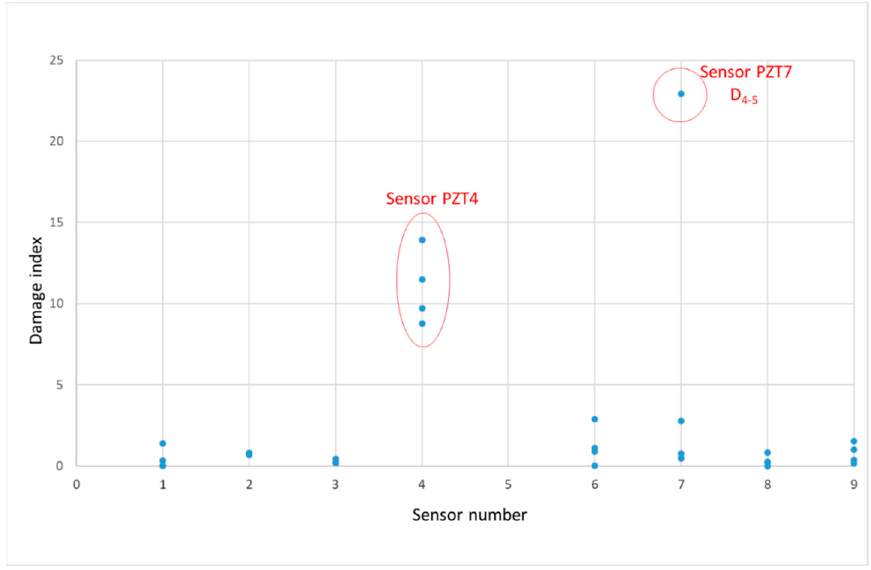
Figure 13. Damage index—beam B.